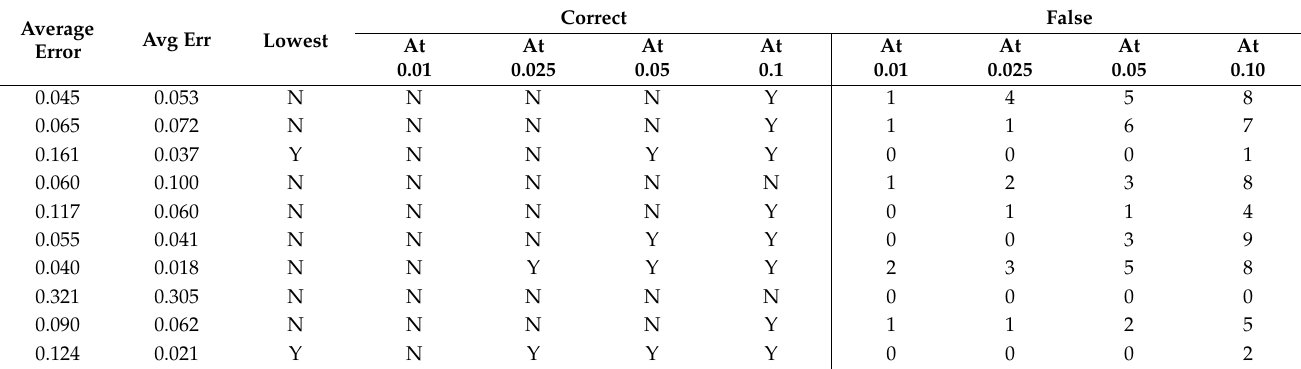
Table A124. Set 2, trials 21–30 summary data (average actual PR values).